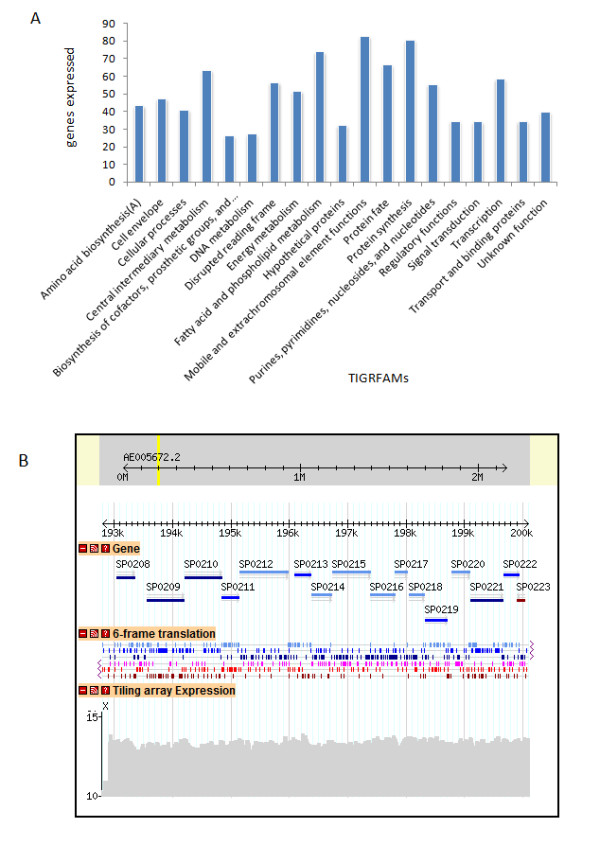
A S. pneumoniae TIGR4 genes expressed in different TIGR protein families (TIGRFAMs). The gene expression is shown as a percentage of the total number of genes present in TIGR4 genome in a particular TIGRFAM category. B. Genome browser visualization of S10, a 15 gene operon (SP0208 - SP0222). Track two shows the DNA sequence translation in six frames and track one shows the genes. The color of the expressed genes is in accordance with the six frame translation. S10 operonic genes SP0208 - SP0222 are present in the forward strand. The "tiling array expression" track clearly demonstrates that all genes predicted in S10 operon are expressed at similar level and this expression is higher than the intensity threshold for expression (11.0).